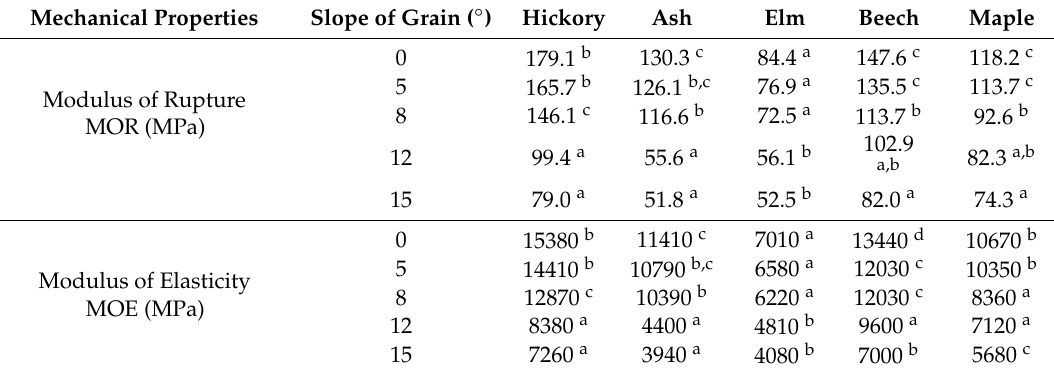
Table 2. Mechanical properties of analyzed wood